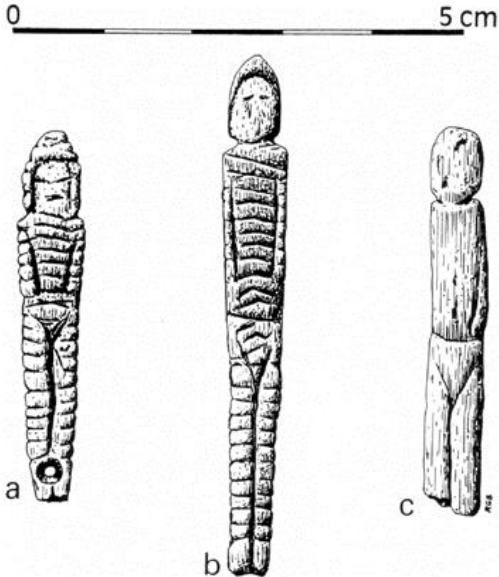
Figure 3. Three small figurines from central Siberia: ( a ) Mal’ta No. 13; ( b ) Mal’ta No. 27 (both are of ivory); ( c ) Buret’ No. 5 (of